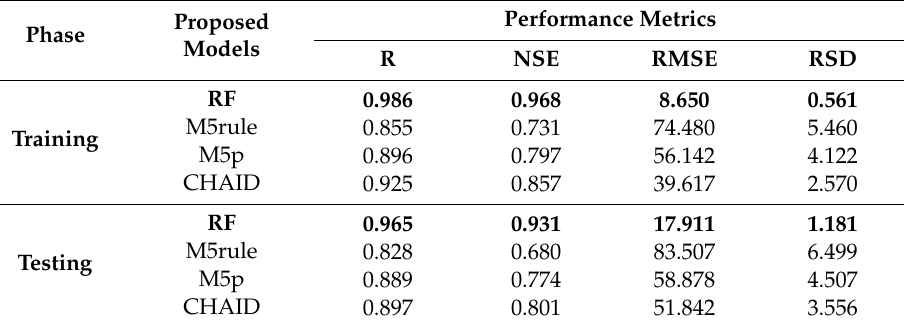
Table 3. Predictive performance of the proposed models for CS prediction.